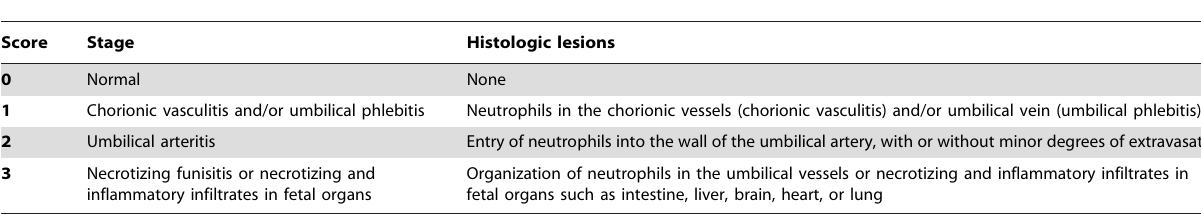
Table 2. Fetal inflammatory response criteria modified from Redline 2006 [32].